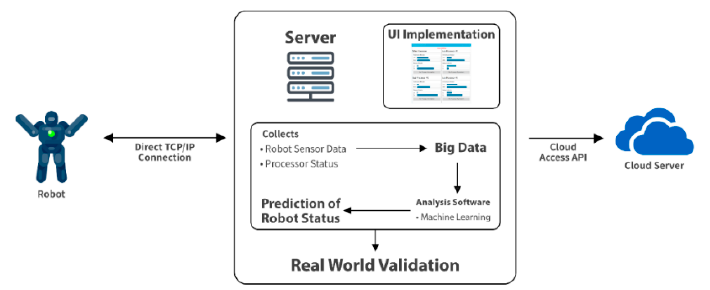
Figure 1. System overview of generic wearable-robot monitoring system (GWRMS).